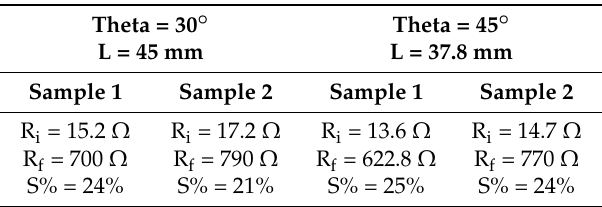
Figure 13. Horseshoe conductive patterns printed on PDMS at various angles. Table 4. Effect of horseshoe angle on initial and final resistances, as well as the maximum strain before failure.